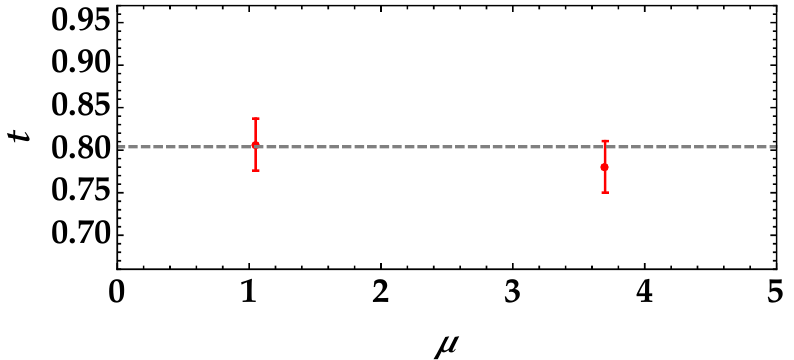
Figure 8. Values of t obtained fitting the data according to Equation (6) as a function of the number of modes. The gray dashed line represents the expected value t = 0.804.